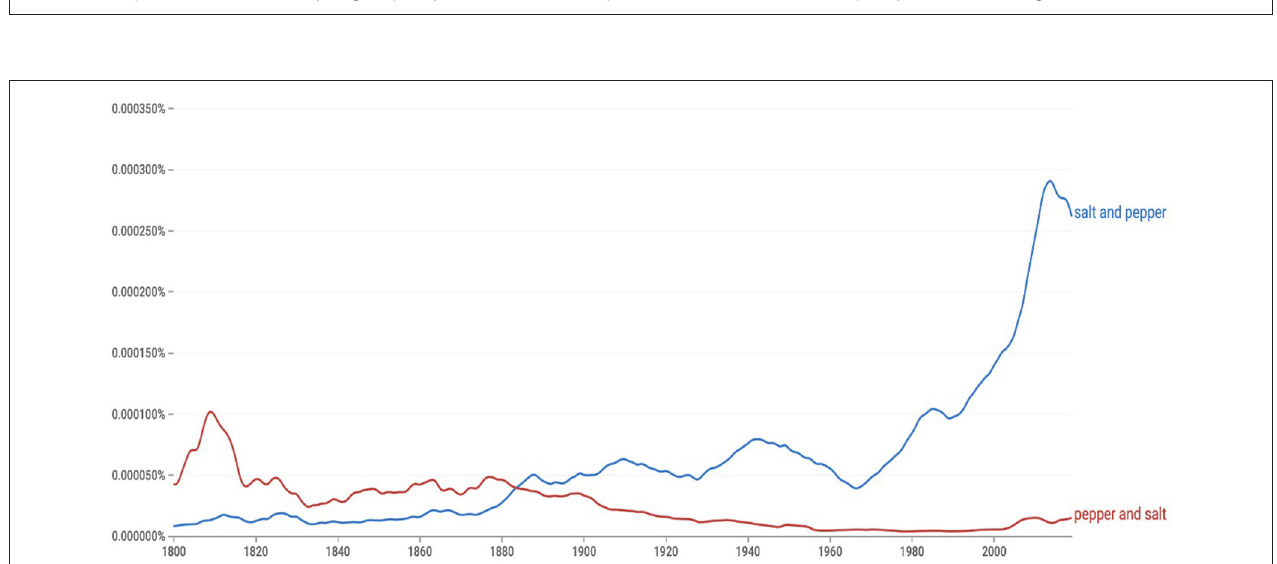
FIGURE 8 | Data from Google Books Ngrams for salt and pepper (blue) and pepper and salt (red).